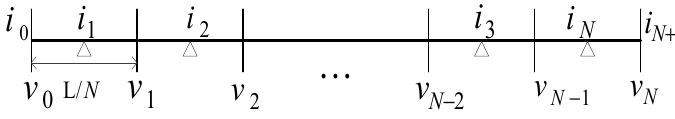
Figure 7. A piecewise model of a transmission line.